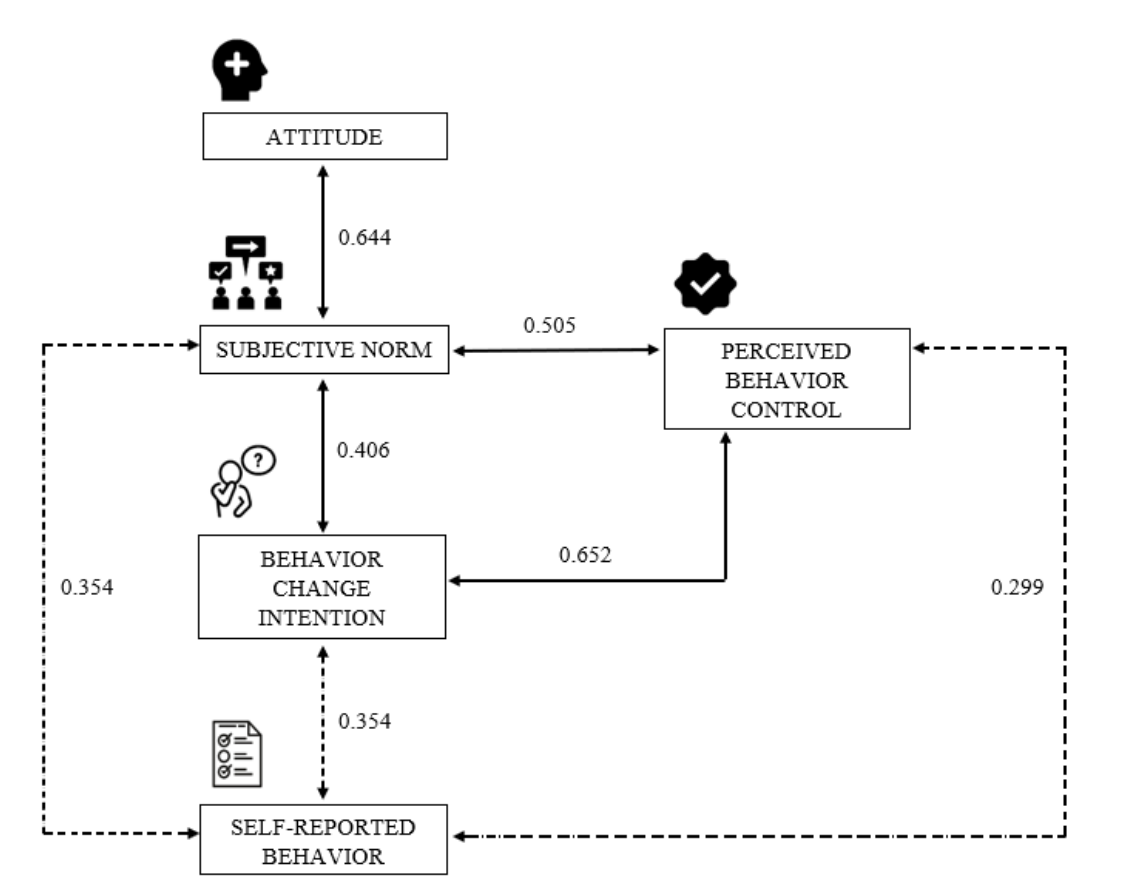
Figure 1. Spearman correlation between the theory of planned behavior constructs, behavior change intentions, and self-reported safe food practice behaviors after the intervention.